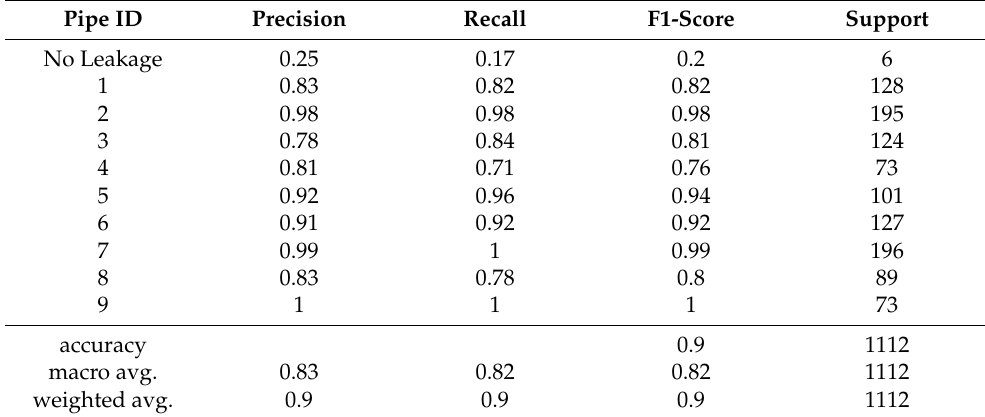
Table 2. Leaking pipe prediction parameters.